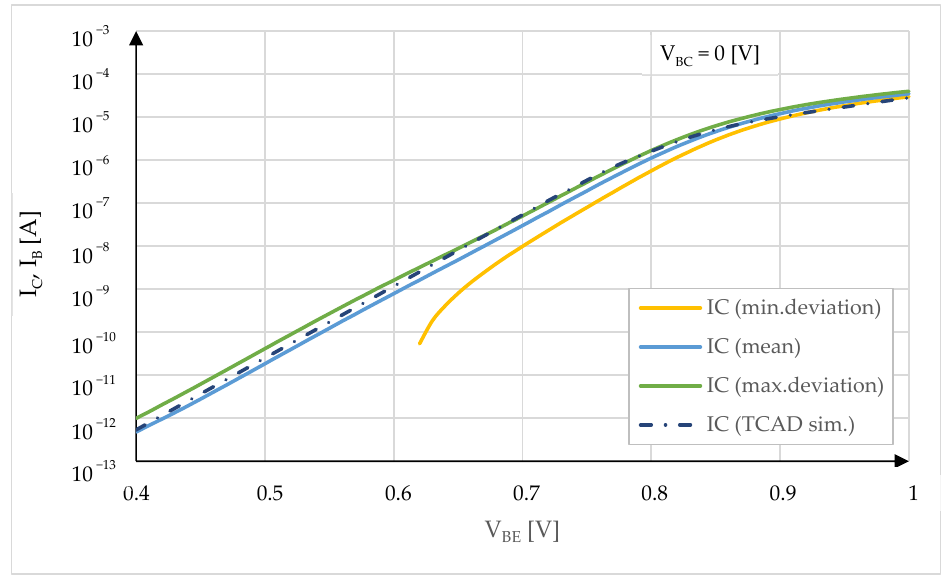
Figure 15. Comparison of the statistics of the measured collector current with the TCAD simulation results (dashed line), the solid lines show the averaged results, and the upper and lower solid lines are the bounds of the standard deviation value.